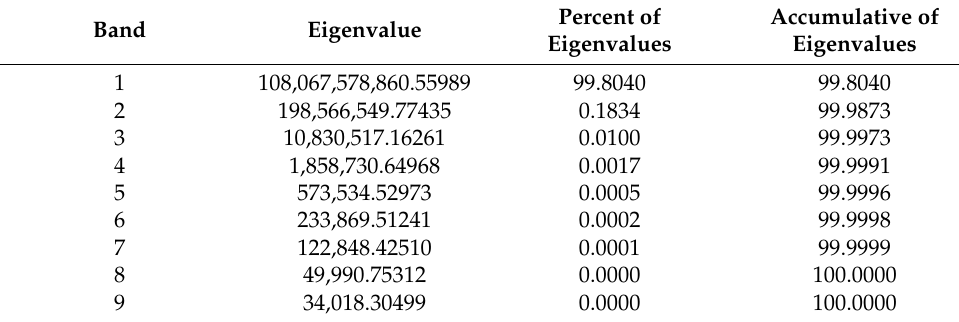
Table 1. Percent and accumulative eigenvalues for